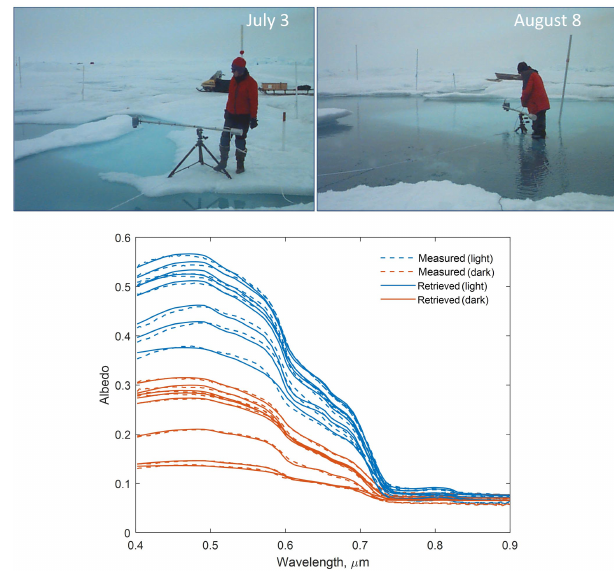
Figure 11. SHEBA-1998 dual pond: photos and spectra (Grenfell et al., 2016), measured (dashed) at the light (blue) and dark (red) parts and simulated (solid). The photographs are taken at the early and late melt season (on 3 July and 8 August,